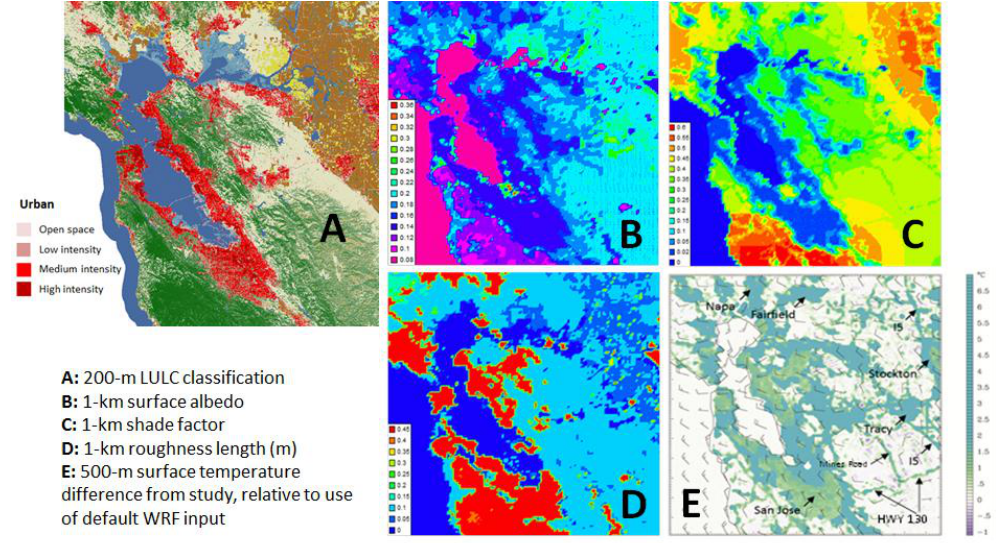
Figure 2. Example analysis for the San Francisco Bay Area (subdomain of D03). ( A ) NLCD 2011; ( E ) WRF-simulated surface temperature difference at 1400 PDT, 15 June 2013. ( E ) WRF-simulated surface temperature difference at 1400 PDT, 15 June